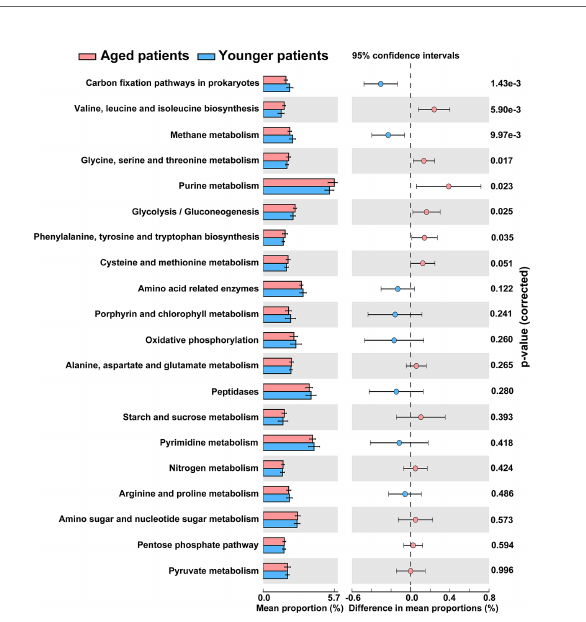
FIGURE 5 | Heat map plot of bacterial functional features of the bacterial community in aged and younger patients as annotated using KEGG pathways.